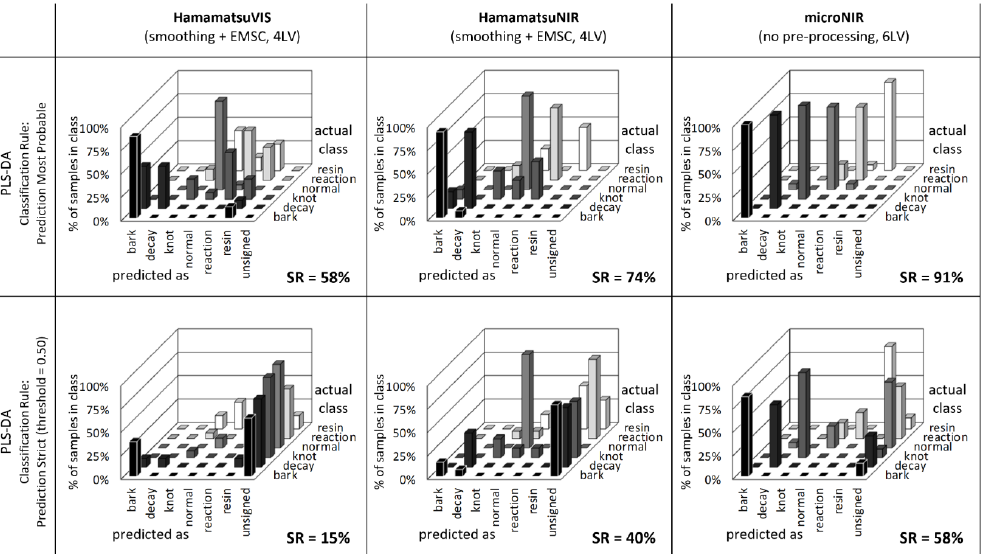
Figure 7. Automatic identification of defects on wood samples with Partial Least Squares discriminant analysis (PLSDA) (SR—success rate).